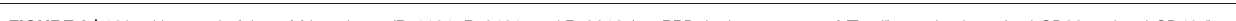
FIGURE 3 | 12h with a pool of three Mtb antigens (Rv1131, Rv2461, and Rv3616c) or PPD, in the presence of (T cell) co-stimulants (anti-CD28 and anti-CD49d). After staining cryopreserved fixed blood cells with an extensive 14-color FACS panel, TNF- α + cells were quantified in each sample. (A) The gating strategy is shown for one sample (TB02) to illustrate the selection of single debris-free TNF- α + cells in unstimulated (AIM-V i.e., medium) and stimulated (antigen pool or PPD) sample. In the left upper table, the number of TNF- α + cells is indicated for each donor. (B) The difference in the absolute number of TNF- α + cells between LTBI and TB was defined by median log 2 fold change [log 2 FC(LTBI/TB)] and calculated separately in adolescents and adults. Blue or red bars represent log 2 FC(LTBI/TB) > 0.5 or < -0.5, respectively. (C) For each of the 11 donors, TNF- α + cells responding to the antigen pool and PPD were used as input in Cytosplore. Input cells were randomly downsampled to 153 events leading to a total of 3,366 TNF- α + cells to explore via hierarchical stochastic neighbor embedding (HSNE). In the upper left HSNE plot, blue, and red dots indicate cells isolated from LTBI or TB patients (color tonality distinguishes adolscents from adults). In the other 11 HSNE plots the colored dots indicate the expression range of 11 singular cellular markers on the cells analyzed (high expression, red; medium expression, yellow; low expression, blue). (D) By applying a Gaussian mean-shift clustering to the FACS data, 17 distinct TNF- α + cell clusters (displayed in the HSNE plot, upper panel) were defined by a unique combination of expressed markers as shown by the heatmap (middle panel). Differences in the size of colored squares indicate the contribution of each marker in defining the specific cell subset, while colors indicate the relative expression of each cellular marker compared to all the other markers (red indicates high; blue indicates low). Lower heatmap (lower panel) shows the proportion of cells composing each cluster per age group of donors (LTBI and TB) and stimuli (PPD and antigen pool). The numbers in the last row refer to the cell